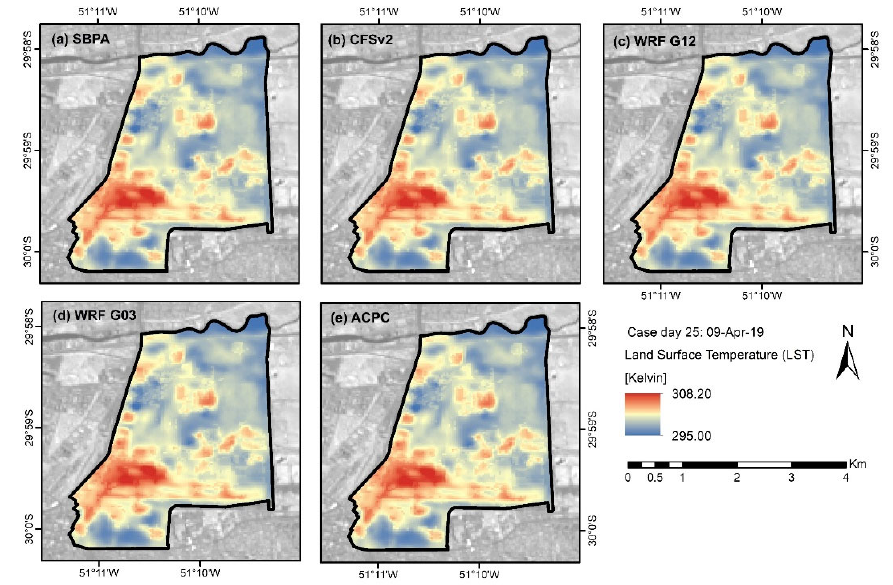
Figure 6. LST images retrieved with atmospheric parameters from ( a ) SBPA, ( b ) CFSv2, ( c ) WRF G12, ( d ) WRF G03, and ( e ) ACPC, for case day 25 (9 April 2019).